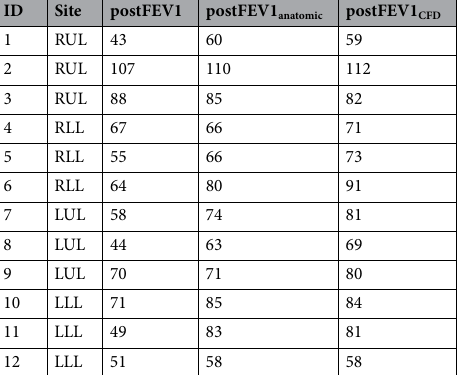
Table 4. Values of the clinically measured FEV1 after the lobectomy surgery (postFEV1) and the estimated post-operative function with the anatomical formula (postFEV1 anatomic ) and the CFD approach (postFEV1 CFD